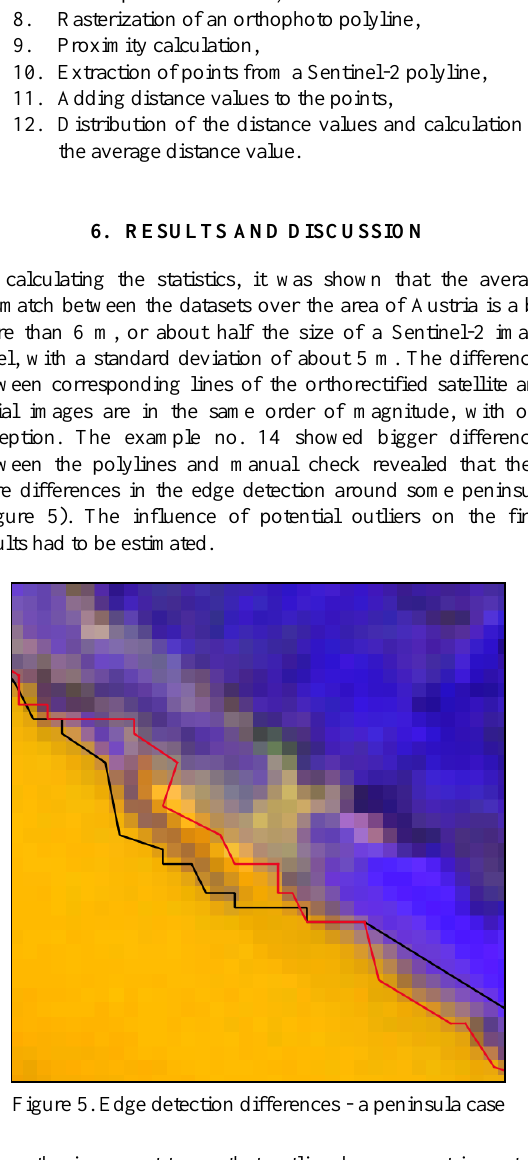
Figure 4. Proximity raster; image covers the area of 8.5 km × 8.5 km